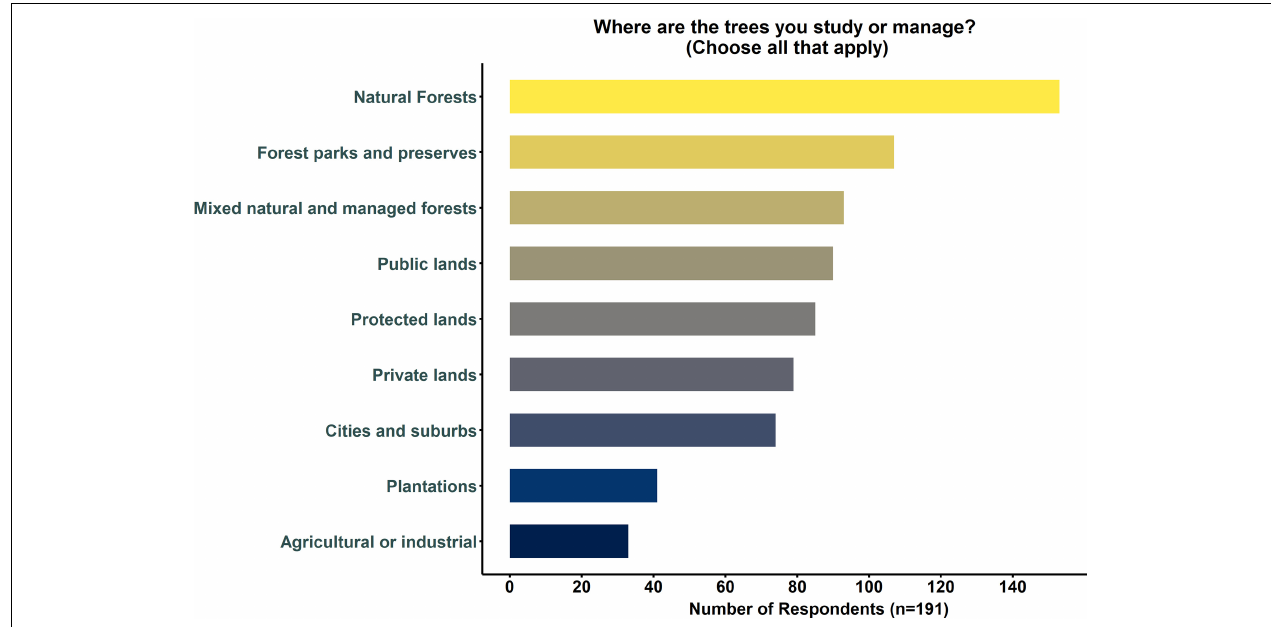
FIGURE 3 | Location of the trees of interest, by land use type, for respondents to an online survey about conducting research and management in the arboreal ecosystem ( n = 191). Each respondent could choose all applicable options.